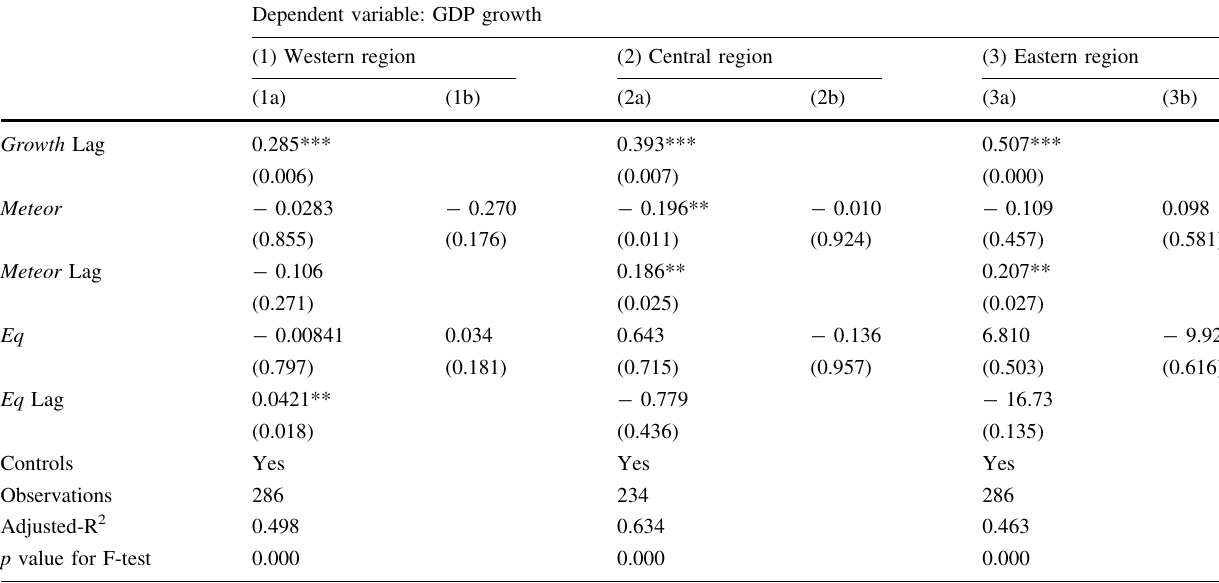
Table 4 Effects of meteorological disasters and earthquakes on macroeconomic growth of the western, central, and eastern regions of China,